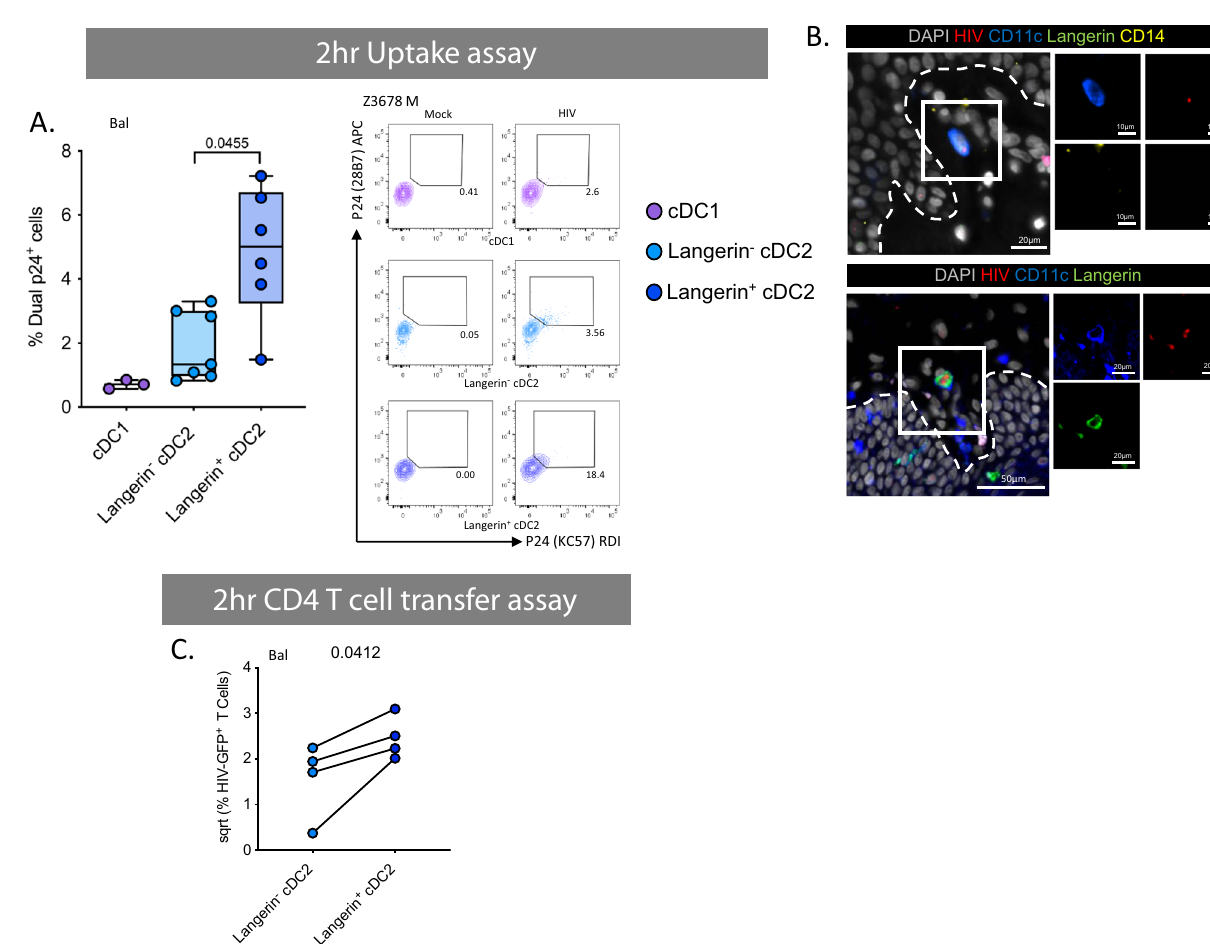
Fig. 8 HIV uptake and 1st phase transfer capacity of dermal dendritic cells. A Enzymatically liberated cells from abdominal skin were FACS isolated to obtain a CD45 + HLA-DR + population and cultured with HIV Bal or HIV Z3678M or Mock treated for 2 h before being washed off three times in PBS. Cells were stained for surface markers and two p24 clones, before analysis by fl ow cytometry. Left: HIV Bal treated cells percentage of dual p24 + cells plotted as box and whisker plots, box representing the upper and lower quartile, central line representing the median, the whiskers the minimum and maximum of each cell subset and each donor represented by an individual dot ( n = 7, n = 3 for cDC1 due to low cell numbers). Statistics were generated using a mixed effects analysis with two-tailed Tukey ’ s multiple comparisons with adjusted P values shown. Right: representative contour plots for HIV Z3678M gating on dual p24 + cells. B Human inner foreskin explants were treated with HIV for 2 – 3 h, before being fi xed, paraf fi n embedded and sectioned. HIV was visualised using RNAscope alongside immuno fl uoerescence for CD11c, CD14 and langerin as well as DAPI to identify Langerin − cDC2 (top) and langerin + cDC2 (bottom). Representative image from n = 3 donors. C FACS isolated cDC2 divided by langerin expression were cultured with HIV Bal for 2 h before being washed off three times. JLTR cells (CD4 T cells with GFP under the HIV promoter) were then co-cultured for 96 h in fi broblast conditioned media. Flow cytometry was used to analyse the percent of GFP + T cells. Data was square root normalised and graphed with each donor represented by an individual dot and lines connecting matched donors ( n = 4). Statistics were generated using a two-tailed paired T test. cDC1 (purple), langerin − cDC2 (light blue) and langerin + cDC2 (dark